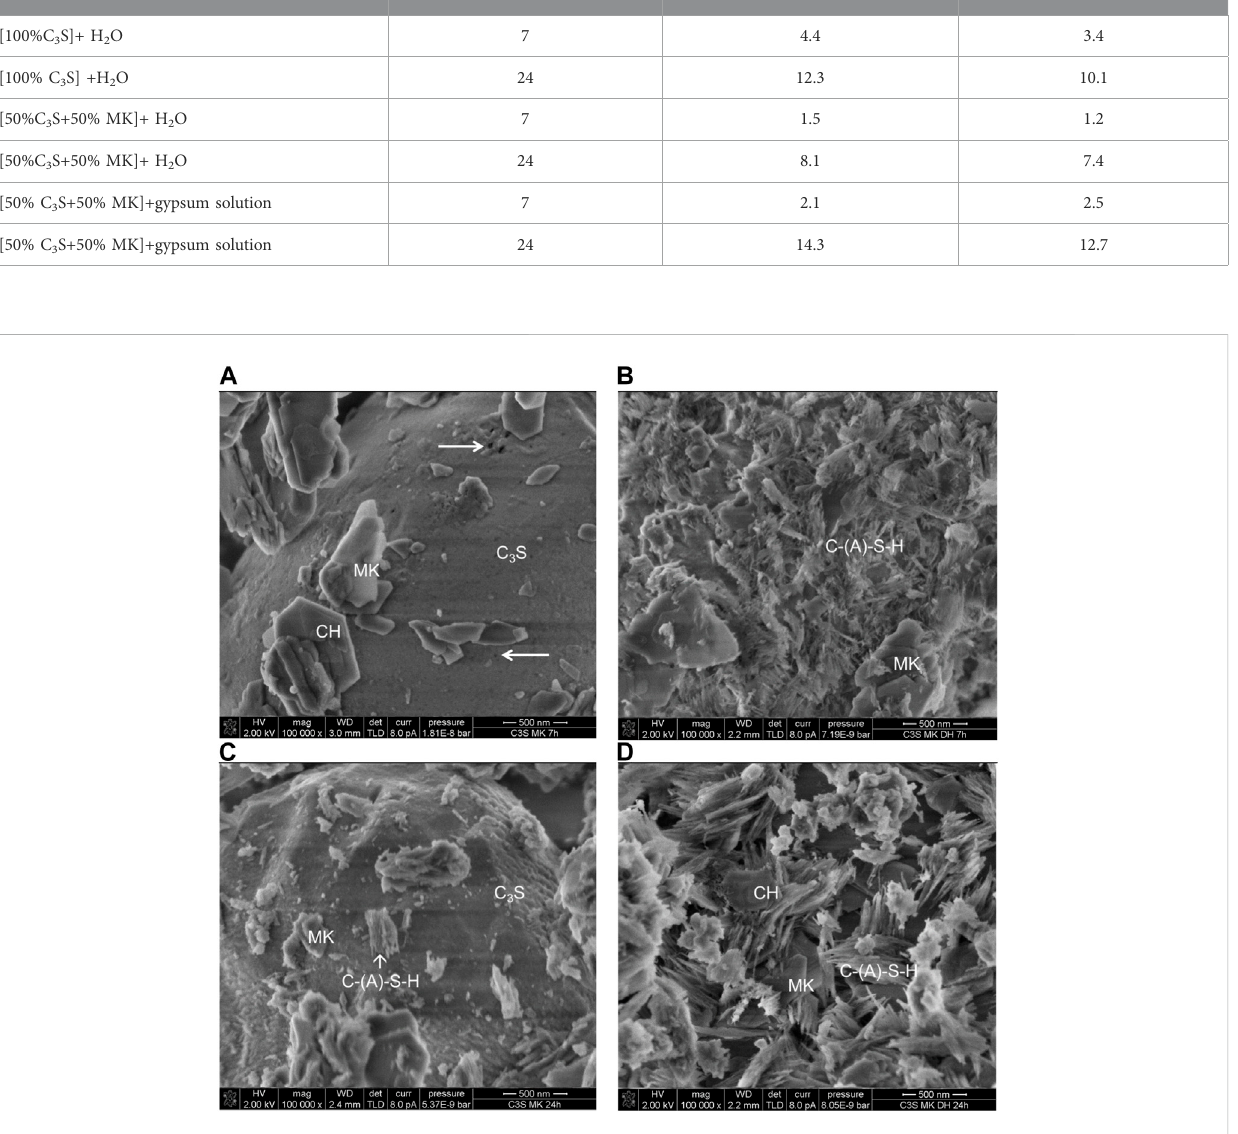
SEM-SE images of [C 3 S + MK] samples hydrated in water (A and C) or saturated gypsum solution (B and D) for 7 h (top row) and 24 h (bottom row). Etch-pits are visualised by